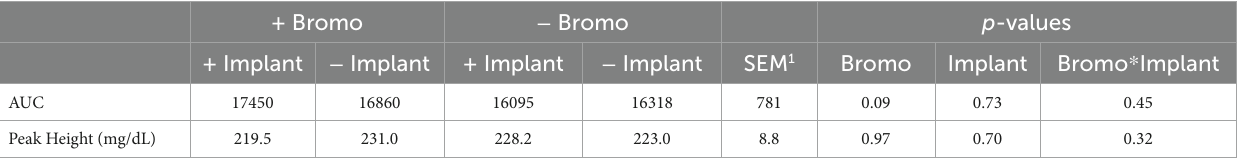
TABLE 4 Area under the curve and peak height of plasma glucose from steers treated with bromocriptine and estradiol/TBA implants before and following an IV glucose bolus. + Bromo − Bromo p -values + Implant −